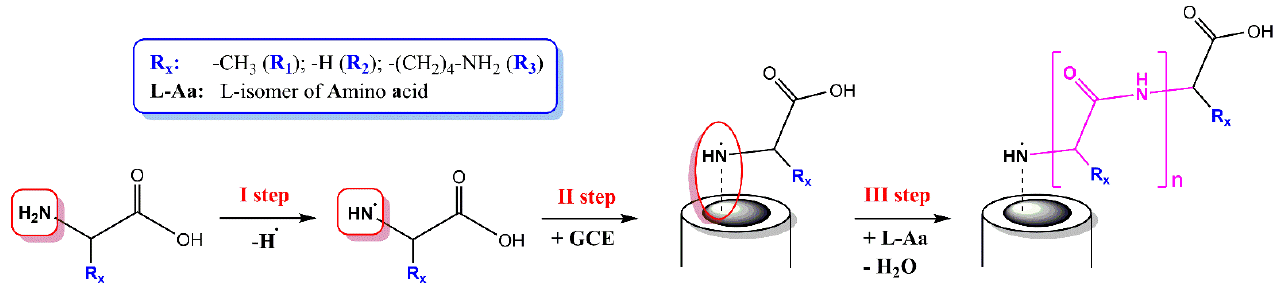
Figure 2. The general mechanism of Amino acid L-isomer electropolymerization on GCE surface.